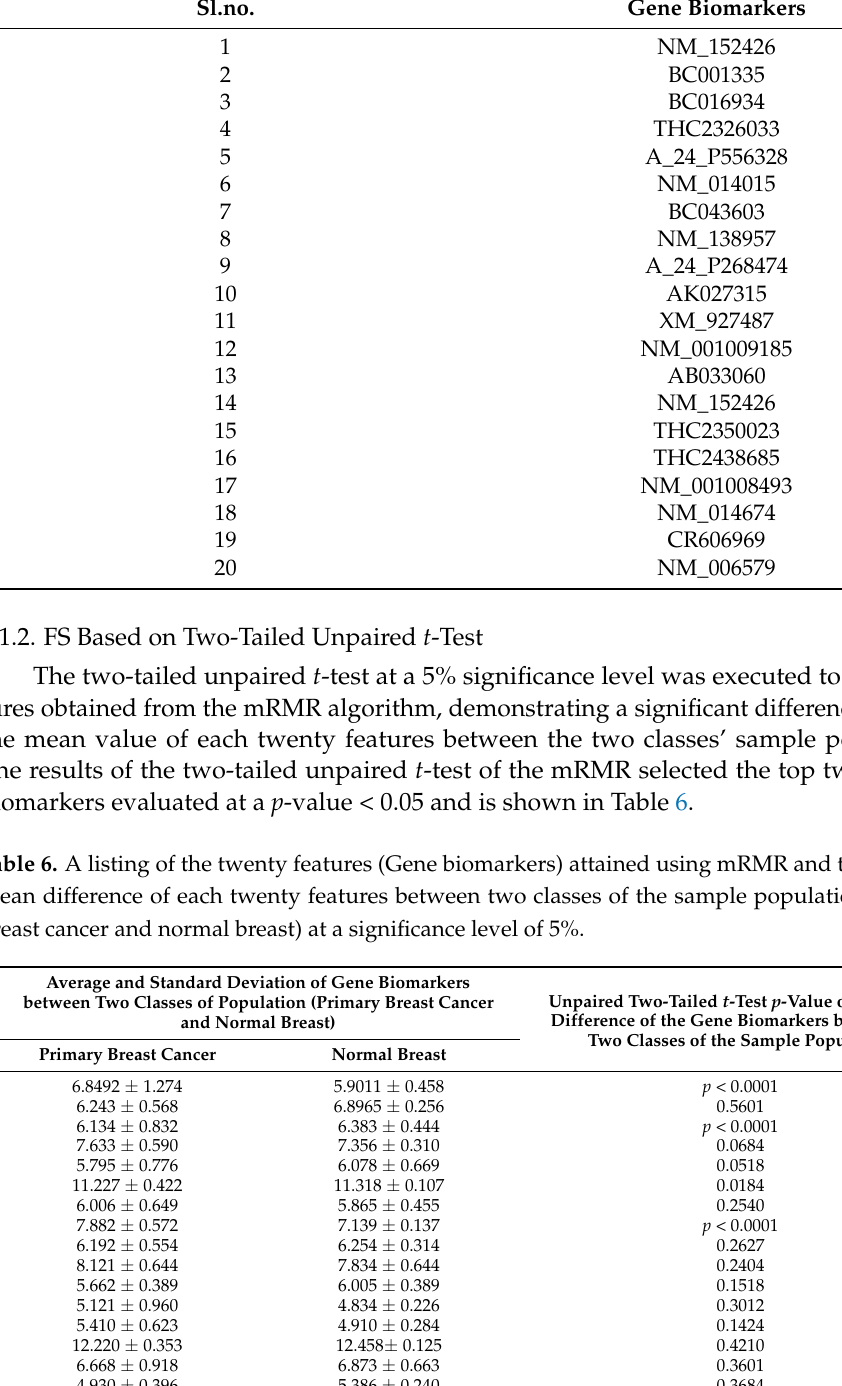
Table 5. List of the top twenty gene biomarkers from the Breast_GSE22820 gene expression microarray dataset using the FCQ variant of the mRMR FS method. Sl.no.